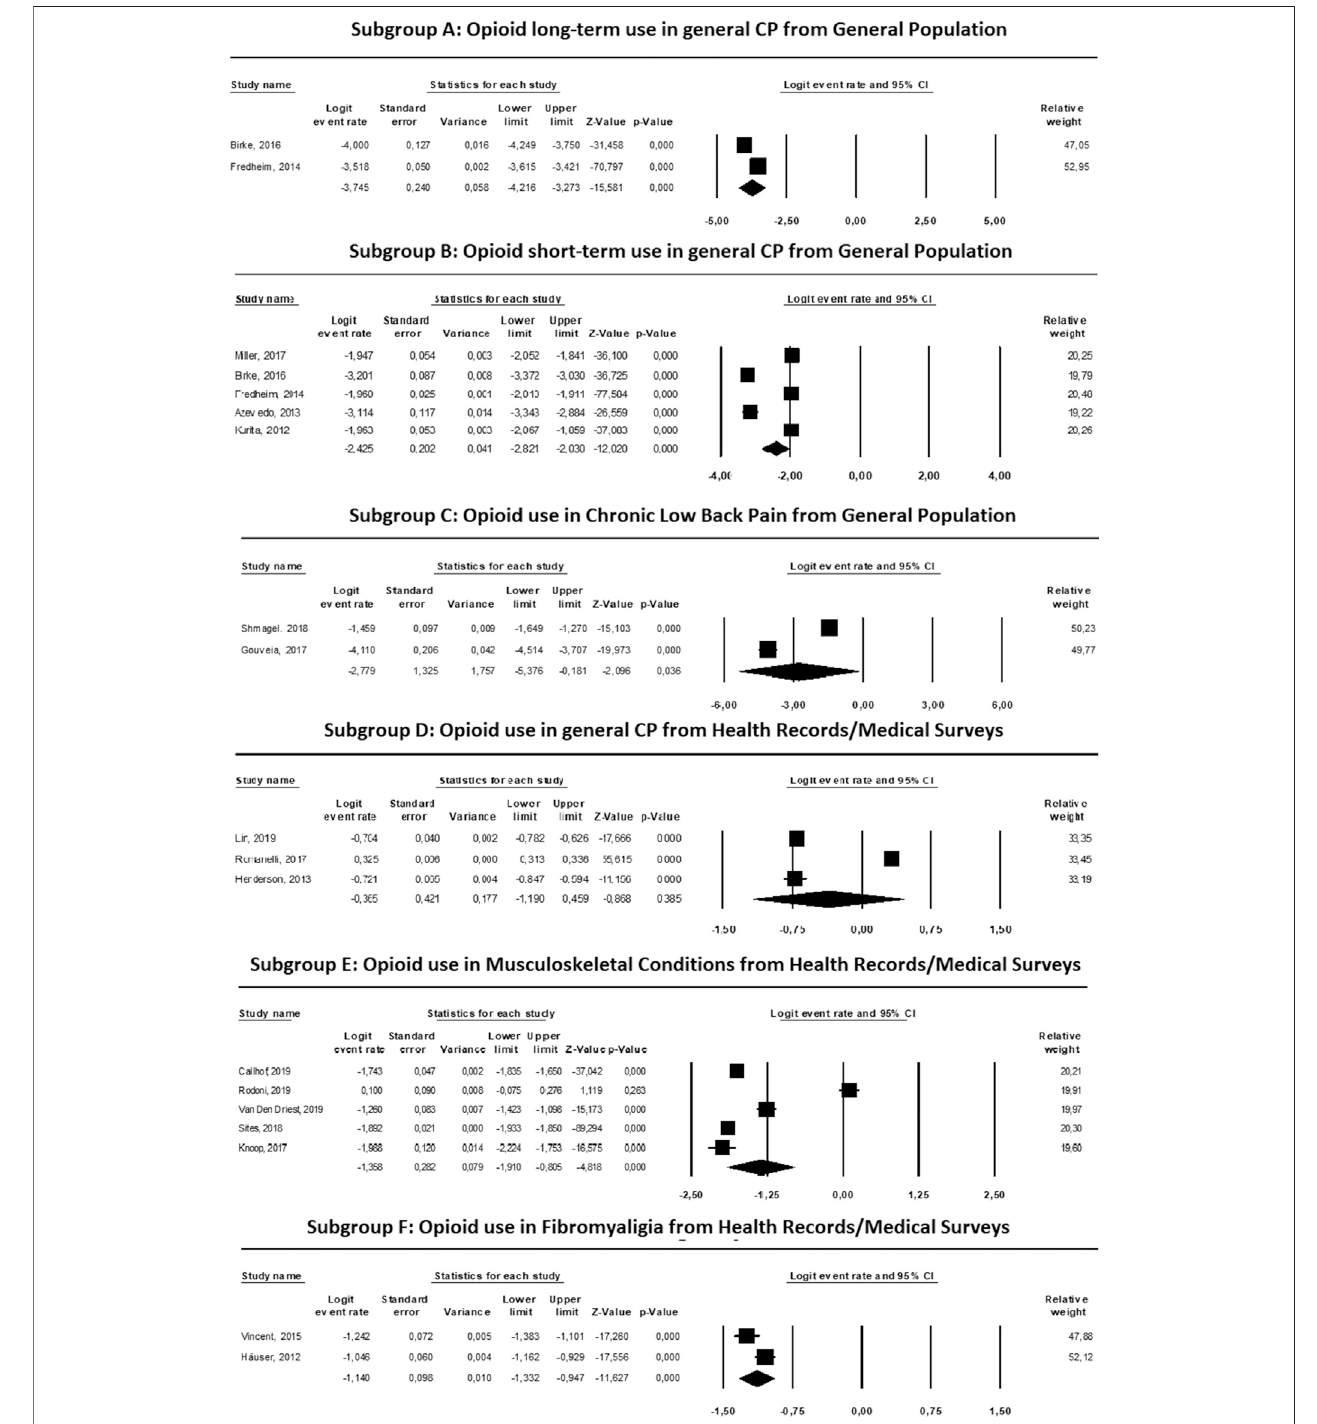
FIGURE 2 | Results and ForestPlots of the meta-analyses for opioid use in different types of pain from diferent sources.